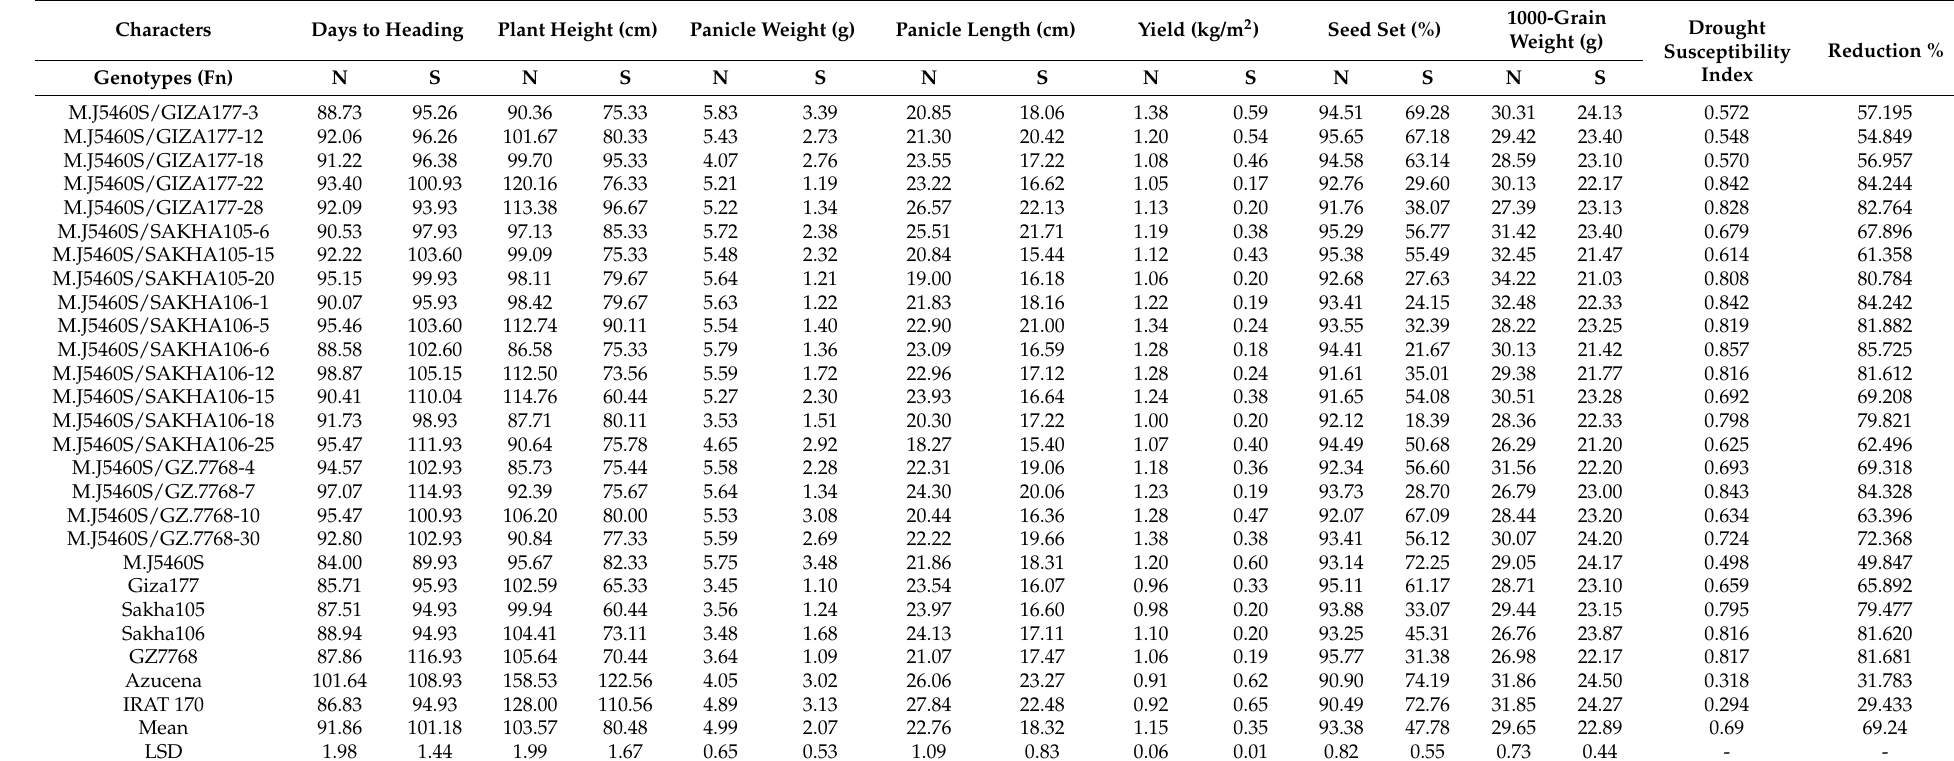
Table 1. Combined mean performance of genotypes for some yield and its component